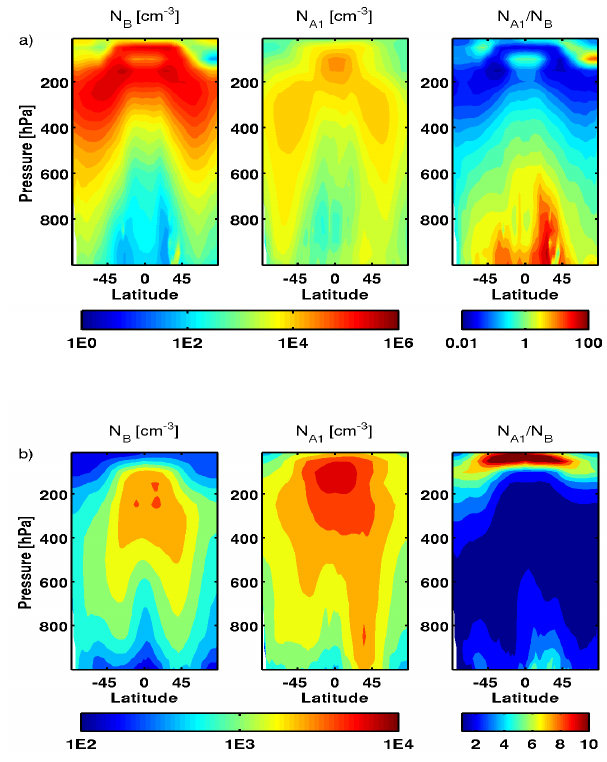
Fig. 14. Annual zonal average concentrations (cm − 3 STP (1013.25hPa, 273.15K)) of (a) nucleation mode aerosol number; (b) sum of Aitken mode number concentration: centre ones exper- iment A1 (using activation nucleation in addition to the standard binary nucleation) as predicted by the GCM ECHAM5-HAM; and right panels show the ratio of the yearly averages for experiments B (only binary nucleation) and A1. Notice the different color scales between figures (published in Makkonen et al.,